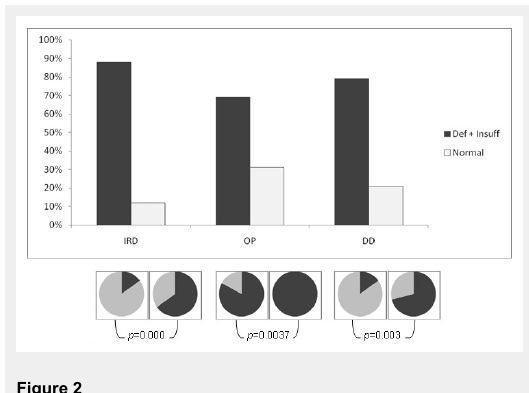
All patients: effects of vitamin D3